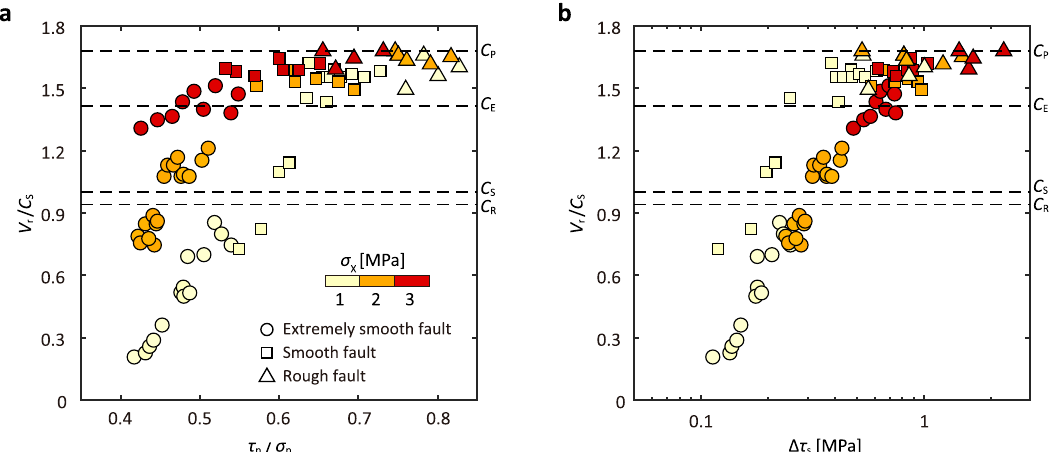
Fig. 3 | Factors controlling rupture speed. a Dependence of rupture speed on fault roughness and the ratio of global peak shear stress to normal stress ( τ p = σ p ). b Dependenceofrupturespeed on faultroughness and staticstress drop 4 τ s . The